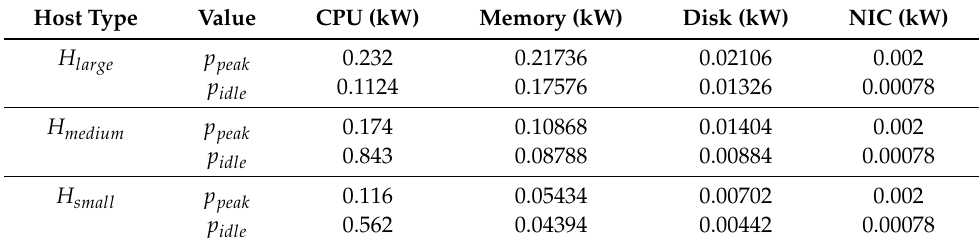
Table 2. Power parameters of the